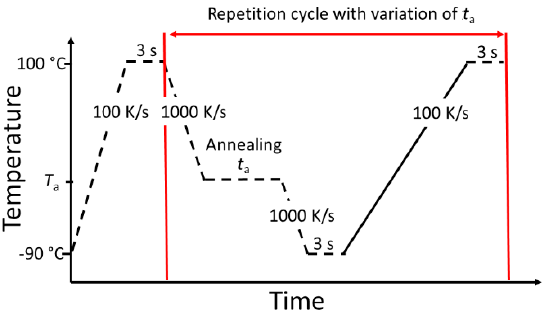
Figure 4. Figure 4. Typical temperature program for the Fast Differential Scanning Calorimetry (FDSC) measurements.